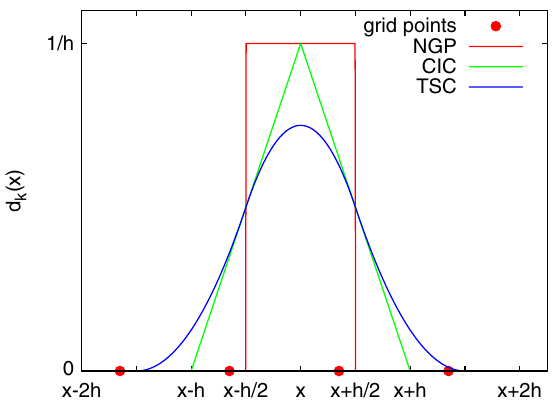
FIG. 1. Three lowest-order CDS in 1D: NGP ( k ¼ 1 ), CIC ( k ¼ 2 ), and TSC ( k ¼ 3 ) in 1D. x denotes the location of a particle, filled circles represent grid points, and h is the grid spacing.